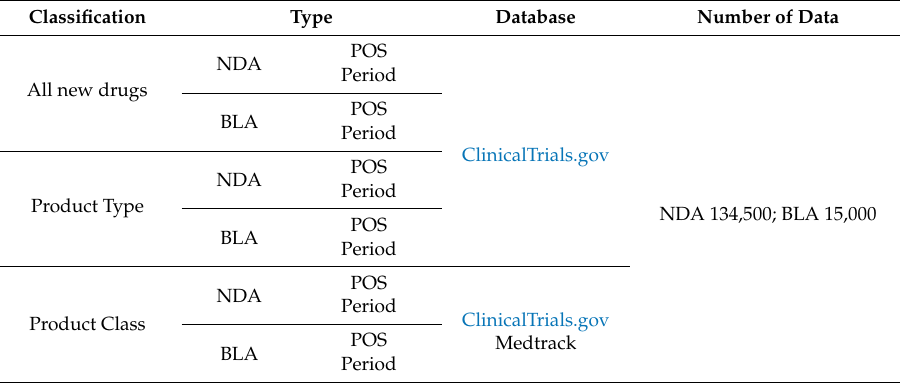
Table 7. Description of analysis data.